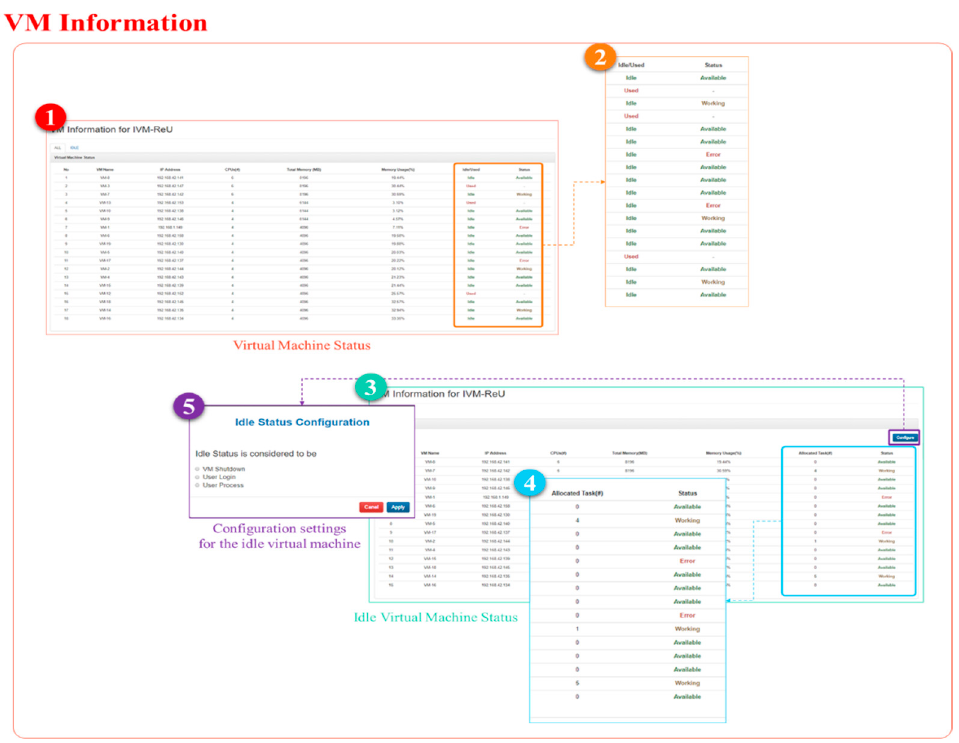
Figure 7. Status information view of virtual